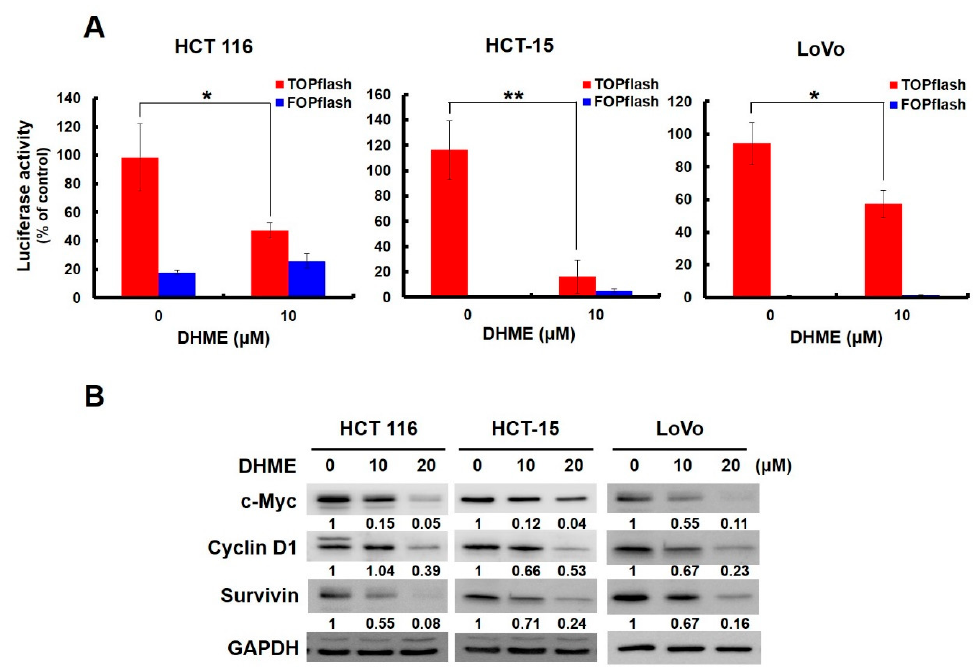
Figure 4. DHME inhibits WNT / β -catenin signaling in CRC cells. ( A ) Suppression of β -catenin–T-cell factor / lymphoid enhancer factor (TCF / LEF)-dependent transcription by DHME. HCT 116, HCT-15, and LoVo cells were transiently transfected with an M50 Super 8x TOPFlash plasmid (TOPFlash),